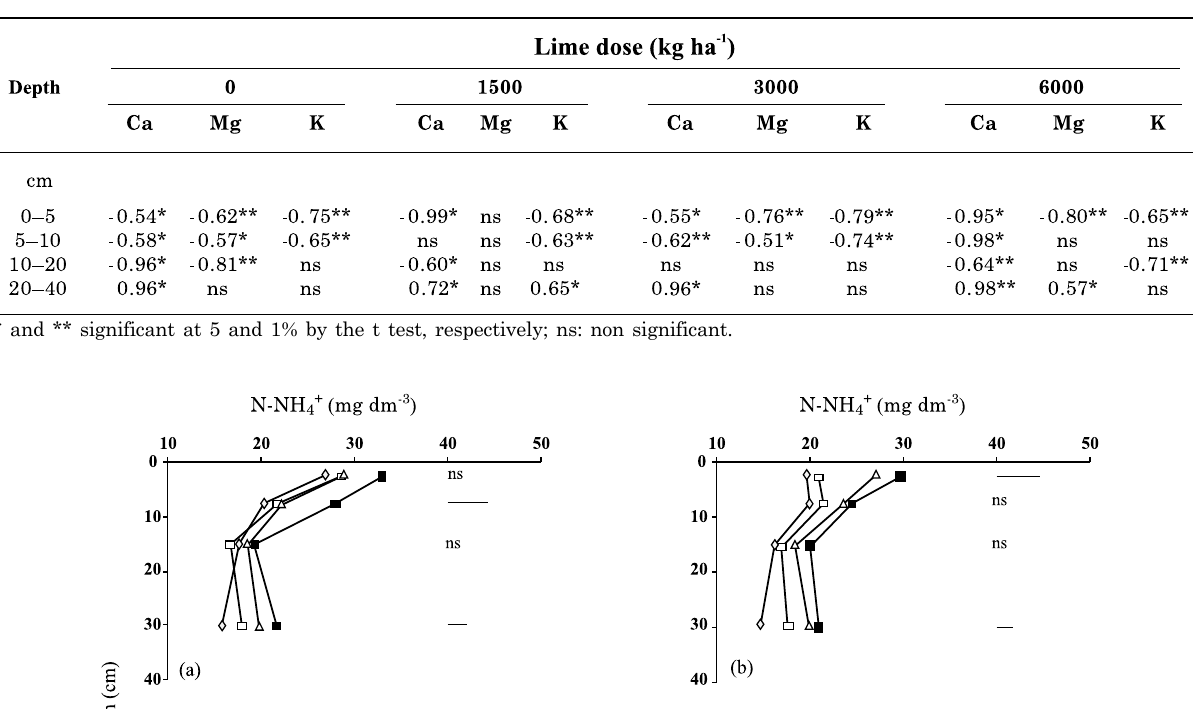
Table 2. Linear correlation coefficients in different layers of soil profile, among Ca, Mg and K levels and nitrate levels provided by increasing nitrogen fertilization in different liming conditions